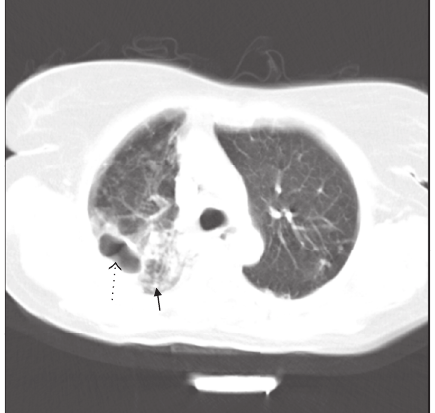
Figure 3: 66-year-old female. Spiral CT scan below the level of left pulmonary artery (lung window). There is cavitary consolidation in posterior segment of right upper lobe (dotted arrow) along with adjacent nodular infiltration (thick